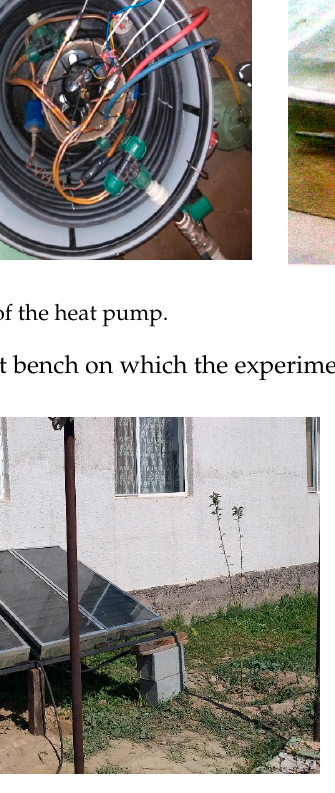
Figure 2. Schematic diagram of the heat pump.